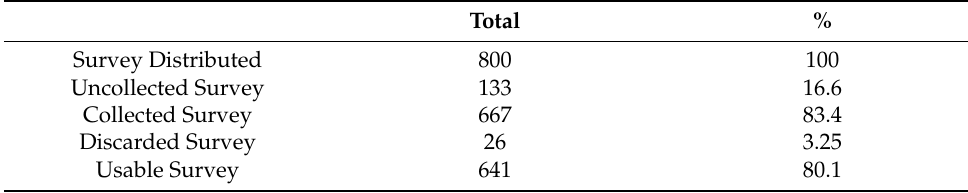
Table 3. Procedure of Data Collection.